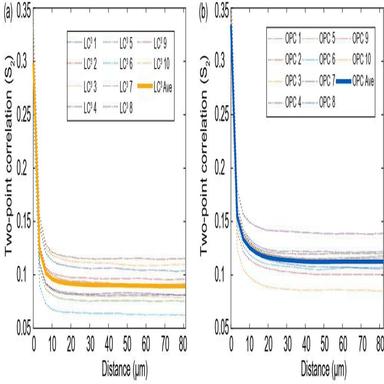
Two-point correlation functions of the microstructure for cement samples with different physical distances in (a) 28-day LC3 and (b) 28-day OPC images.